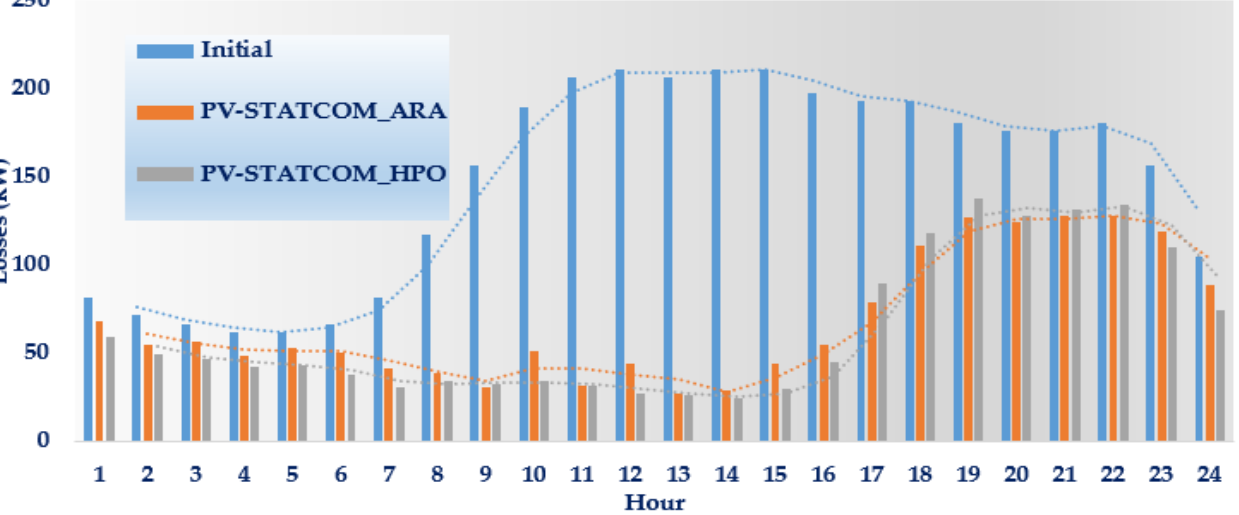
Figure 6. Hourly power losses based on the proposed HPO and ARA versus the initial case for IEEE 33-distribution feeder.